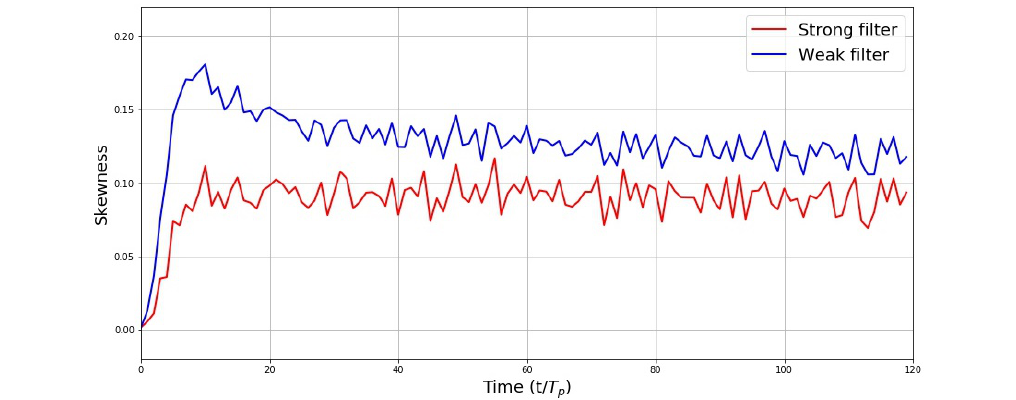
Figure 9. Same as Figure 8 for the time evolution of